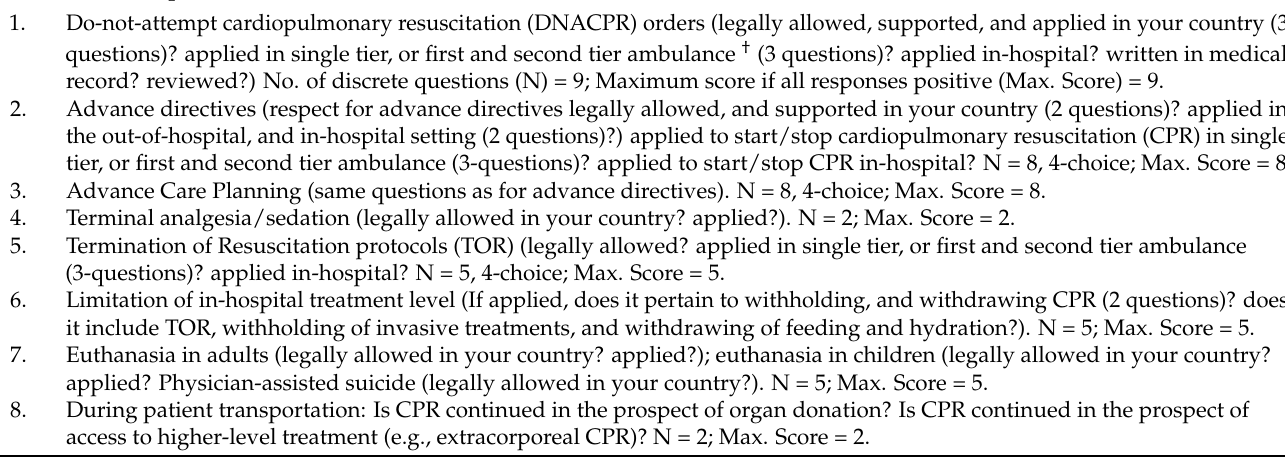
Table 1. The 2019 Ethical Practices